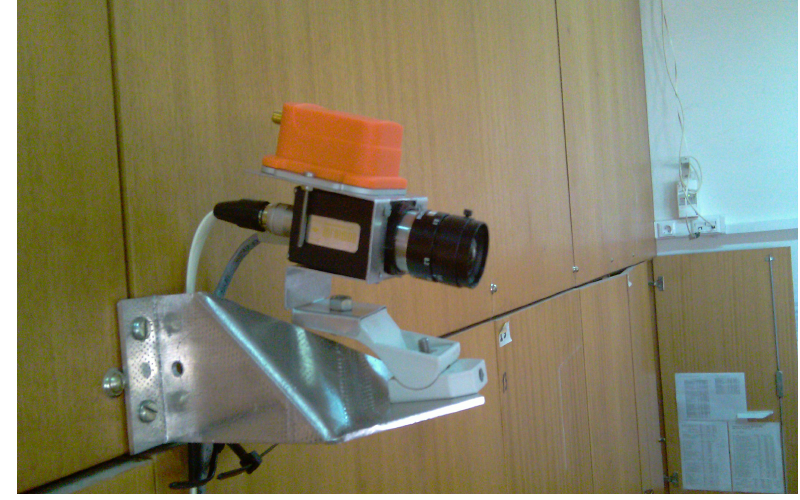
Figure 9. Experimental setup for a smart sensor. AVT Prosilica GC650C camera coupled with a Xsens MTx inertial sensor mounted on the wall. We